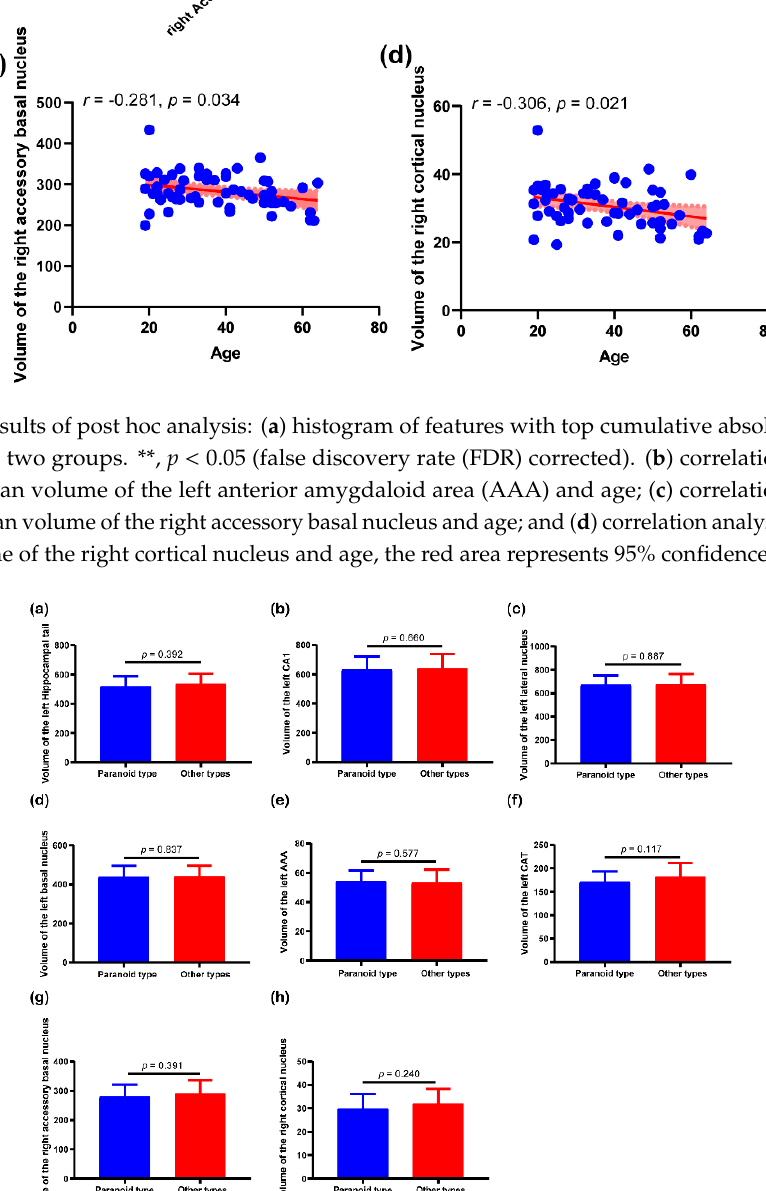
Figure 5. T -test results of mean volume of the ( a ) left hippocampal tail, ( b ) left Cornu Ammonis 1